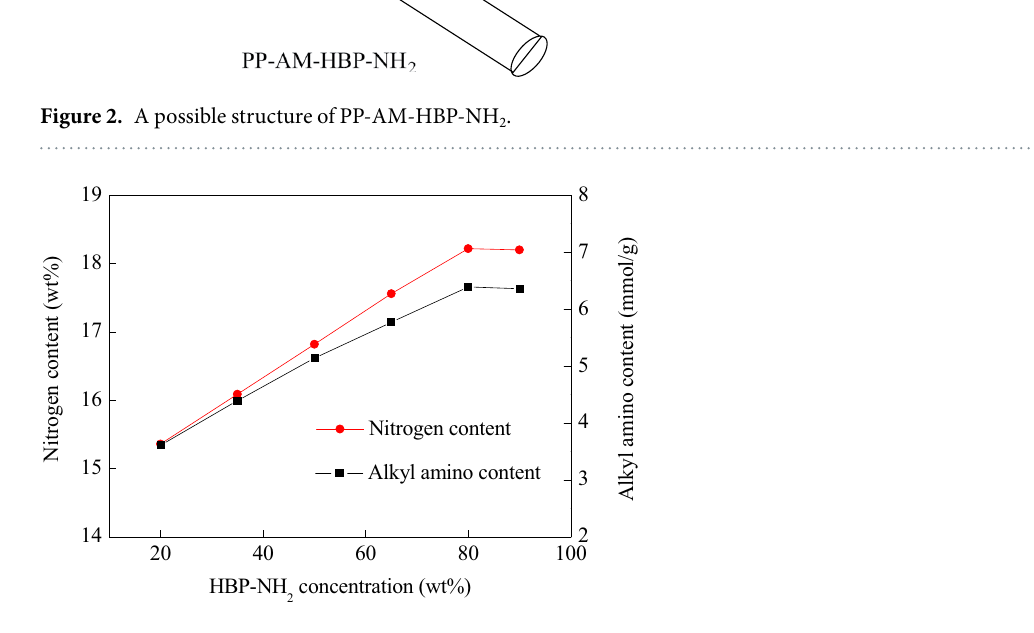
Figure 3. Nitrogen content and alkyl amino content of PP-AM-HBP-NH 2 prepared in various concentration of